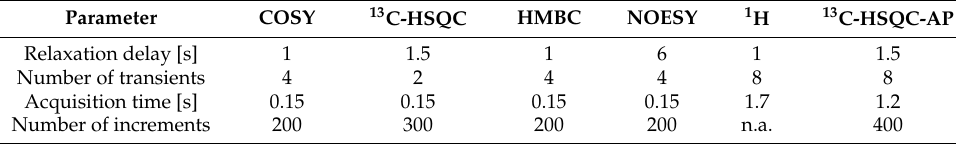
Table 4. Experimental parameters for data acquisition for the NMR